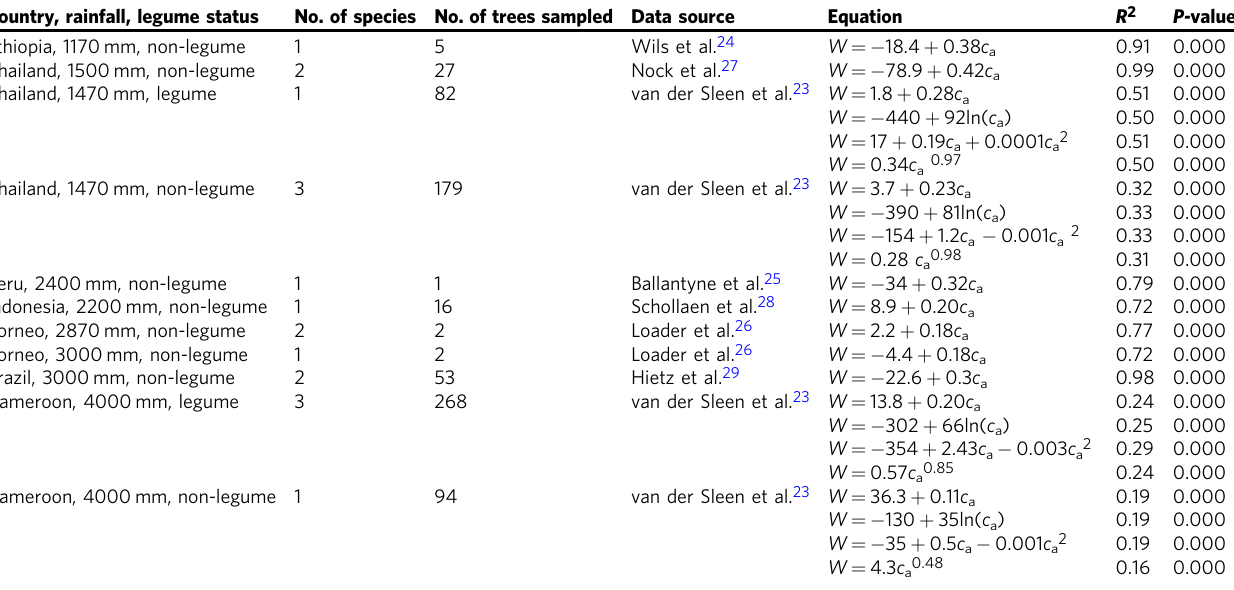
Table 1 Signi fi cant bivariate relationships between inherent water-use ef fi ciency ( W μ mol mol − 1 ) and atmospheric [CO 2 ] ( c a ppm) for canopy-dominant trees in tropical biomes (minimum period = 1915 – 1995) Country, rainfall, legume status No. of species No. of trees sampled Data source